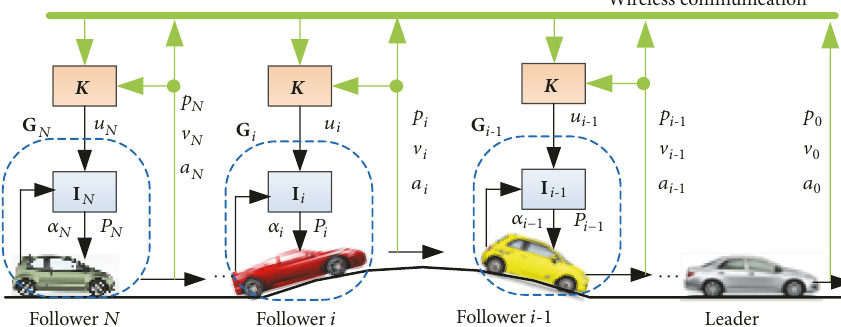
Figure 1: The heterogeneous platoon influenced by environments and interacting by uncertain